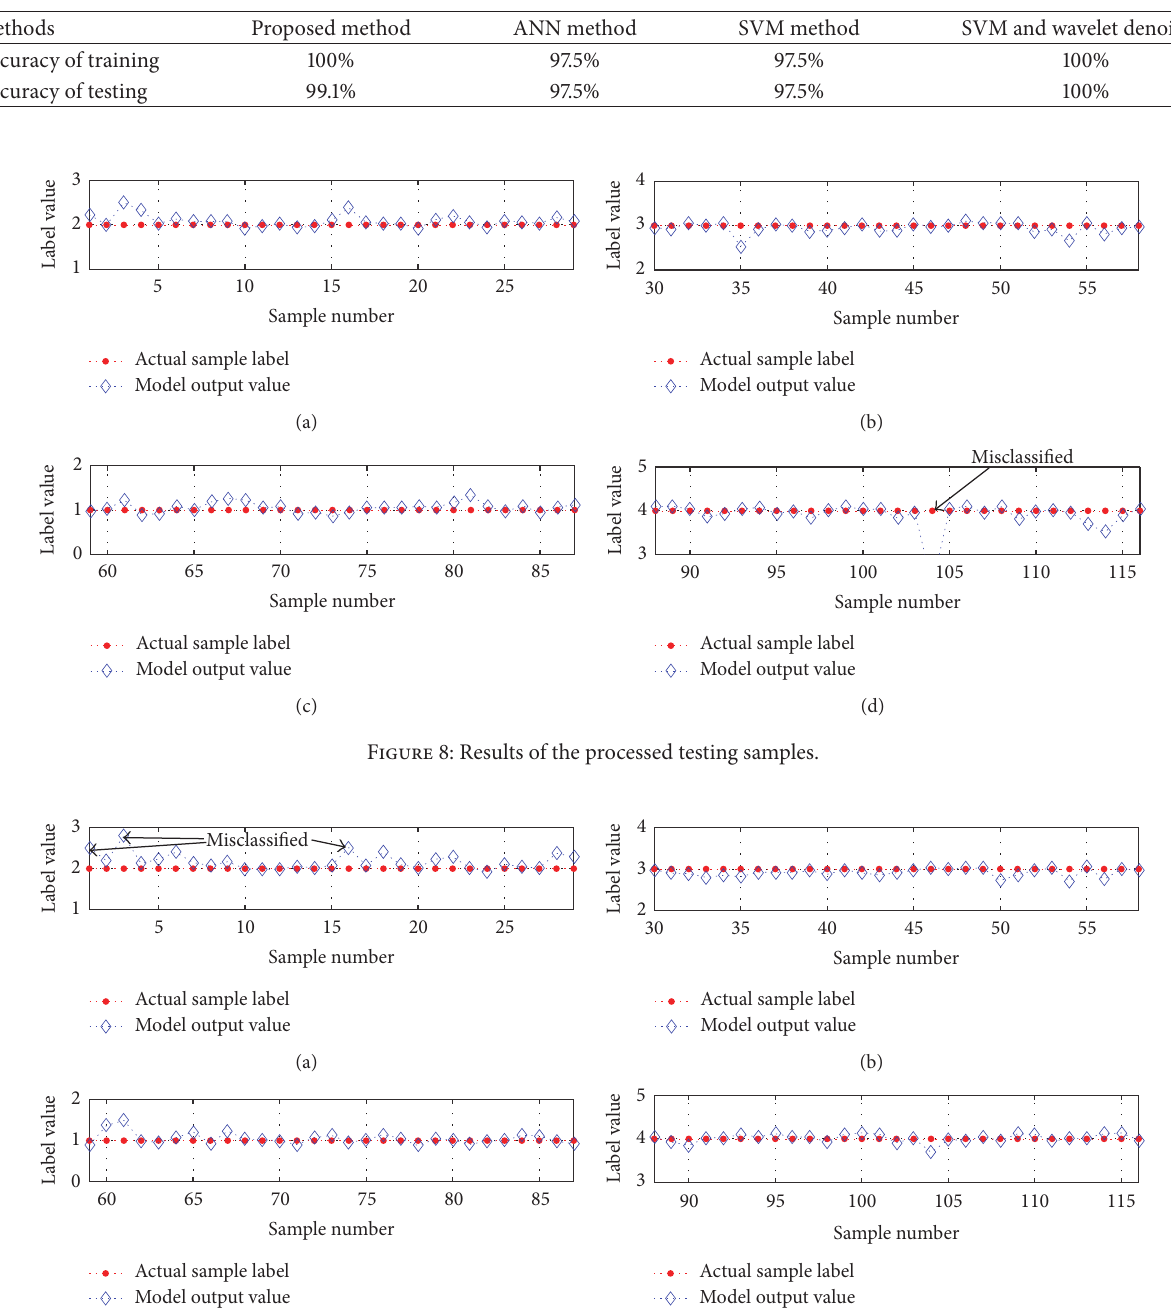
Table 3: Comparative study between the proposed method and the previous work.